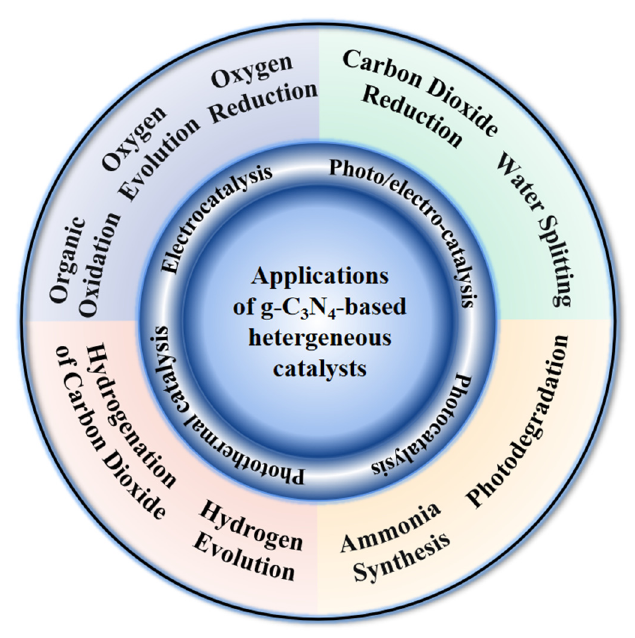
Figure 1. Applications of g-C 3 N 4 in heterogeneous catalysis.